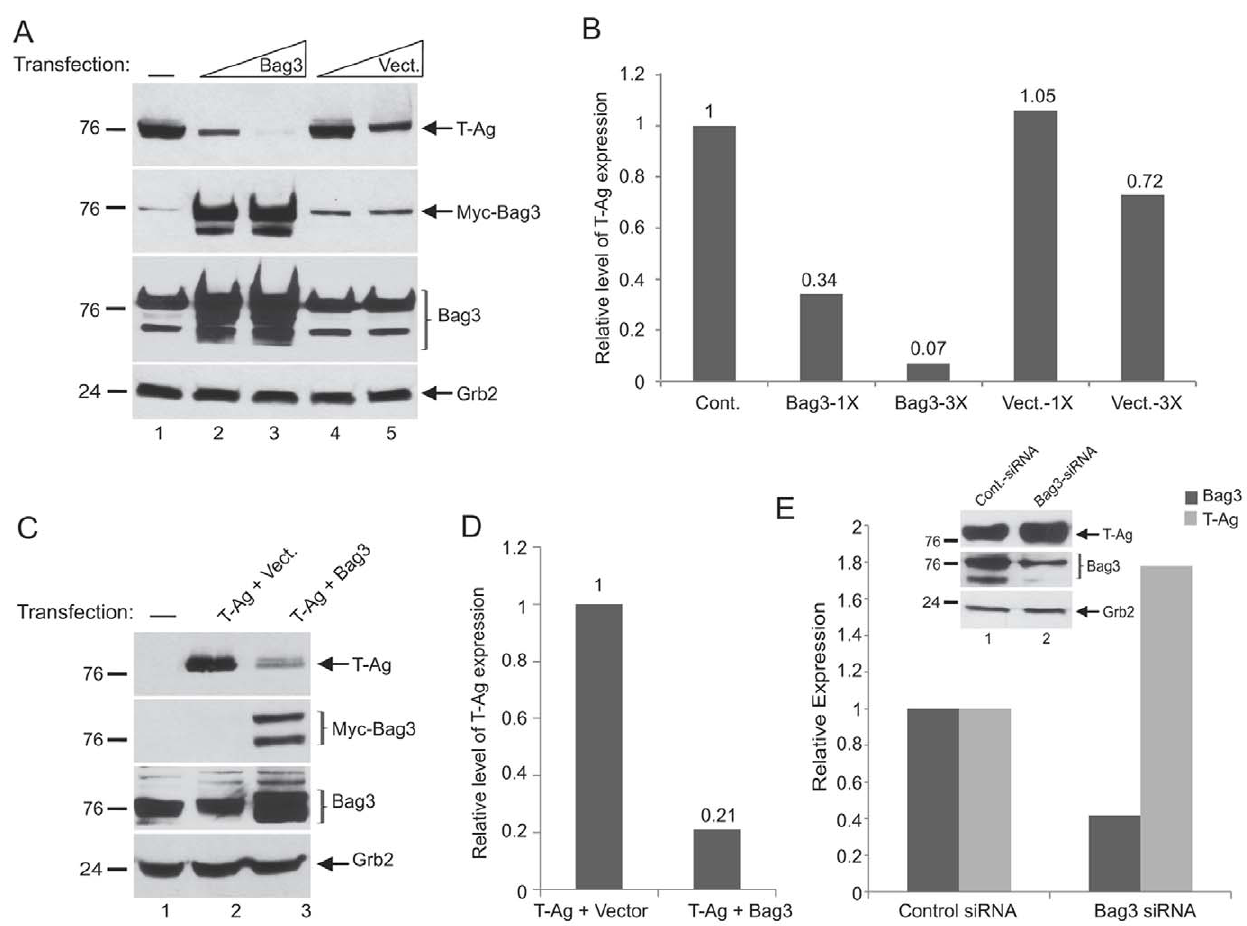
Figure 1. Effect of Bag3 on T-Ag expression in JCV transformed cells. A. BSB8 cells were transfected with empty vector or with an expression plasmid encoding Bag3 in a dose dependent manner. Western blot analyses were performed using whole cell protein extracts prepared at 48 hour post-transfections using specific antibodies recognizing T-Ag, Myc-tag, and Bag3 proteins. Western blot analysis of the same extracts using anti-Grb2 antibody was used as loading control. B. Relative intensity of the bands corresponding to T-Ag from panel A determined by densitometry is shown as a bar graph. C. Western blot analyses of protein extracts from U-87MG cells after transfection with plasmids encoding T-Ag and Bag3 using specific antibodies for T-Ag, Myc-tag, and Bag3 proteins. Western blot analyzsis of same extracts with anti-Grb2 antibody was used as loading control. D. Relative intensity of the bands from experiments illustrated in Panel C are shown as a bar graph. E. BSB8 cells were transfected with a Bag3 siRNA or a control non-targeted siRNA and expression of T-Ag and Bag3 was examined by Western blot analysis. Relative intensity of the bands corresponding to T-Ag and Bag3 were densitometrically determined and normalized to those from Grb2, and illustrated by a bar graph.